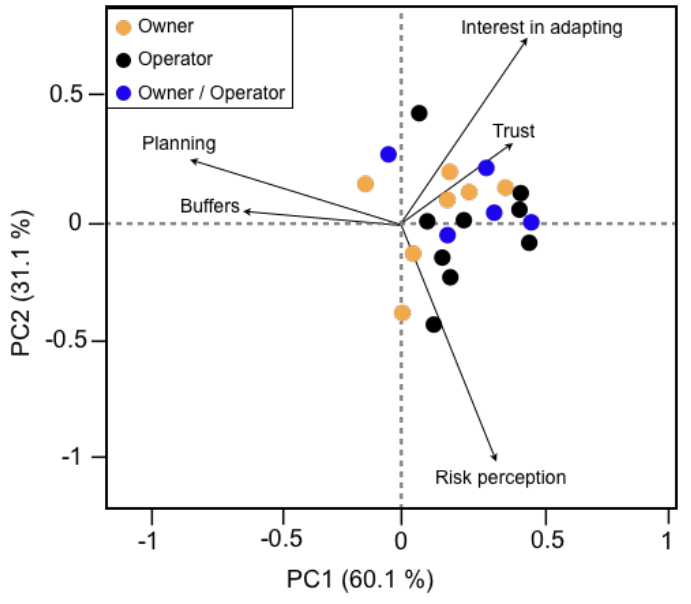
Figure S2. PCA of the 5 adaptive capacity indicators at the individual